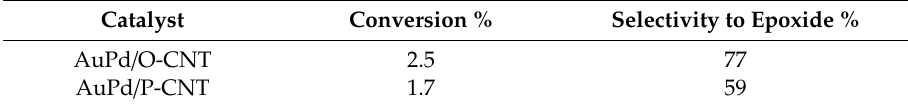
Table 1. Oxidation of cyclooctene using AuPd / O-CNT and AuPd / P-CNT. Catalyst Conversion %